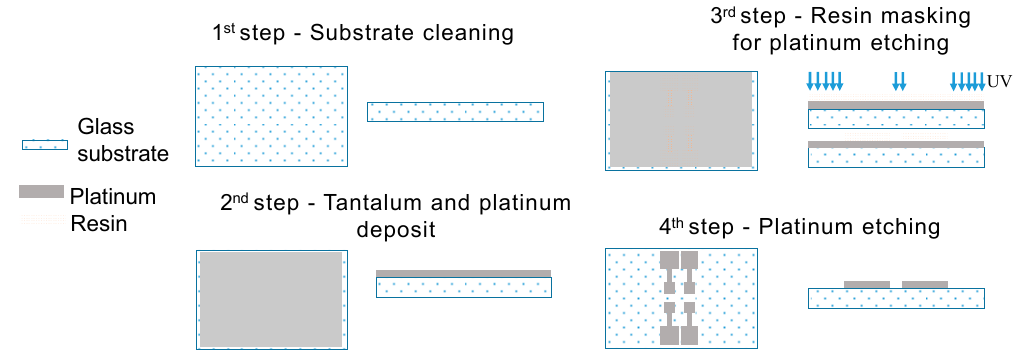
Figure 11. Realization process for the functional part.